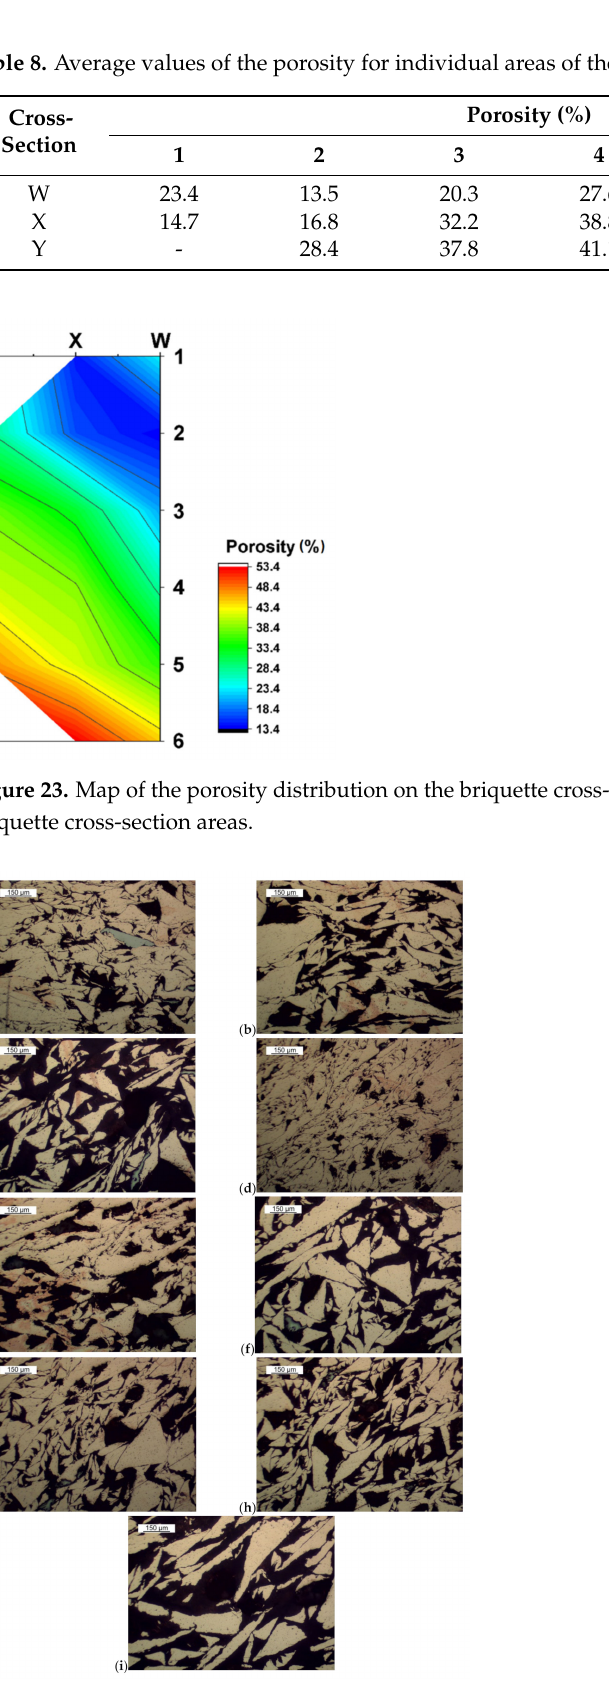
Figure 24. Microstructures of the selected areas of the cross-sections of the briquette: ( a ) W1, ( b ) W3, ( c ) W5, ( d ) X1, ( e ) X3, ( f ) X5, ( g ) Y1, ( h ) Y3, ( i )